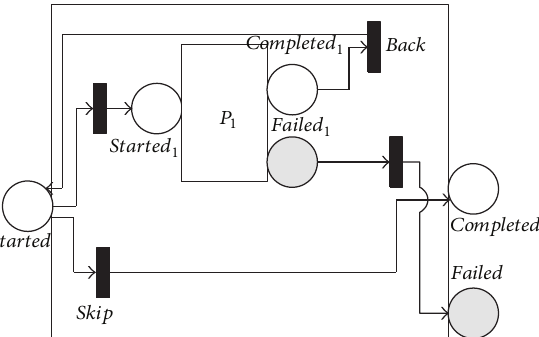
Figure 8: NMSPN model of the repeat-while process.